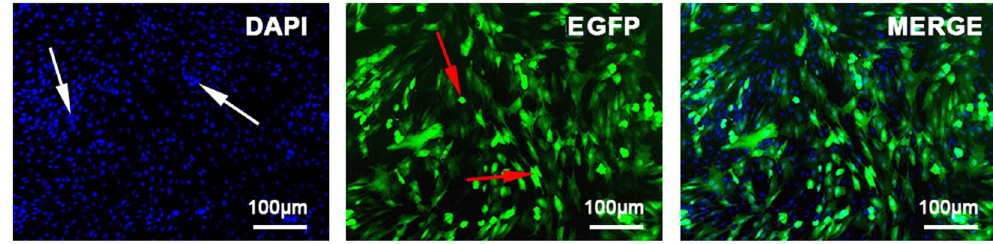
Figure 2. Immunofluorescence images of Ad-hAPN-EGFP (red arrow) in BMSCs. After transfection for 36 h, cell nuclei were stained with DAPI (white arrow). The transfection efficiency was up to 95%.